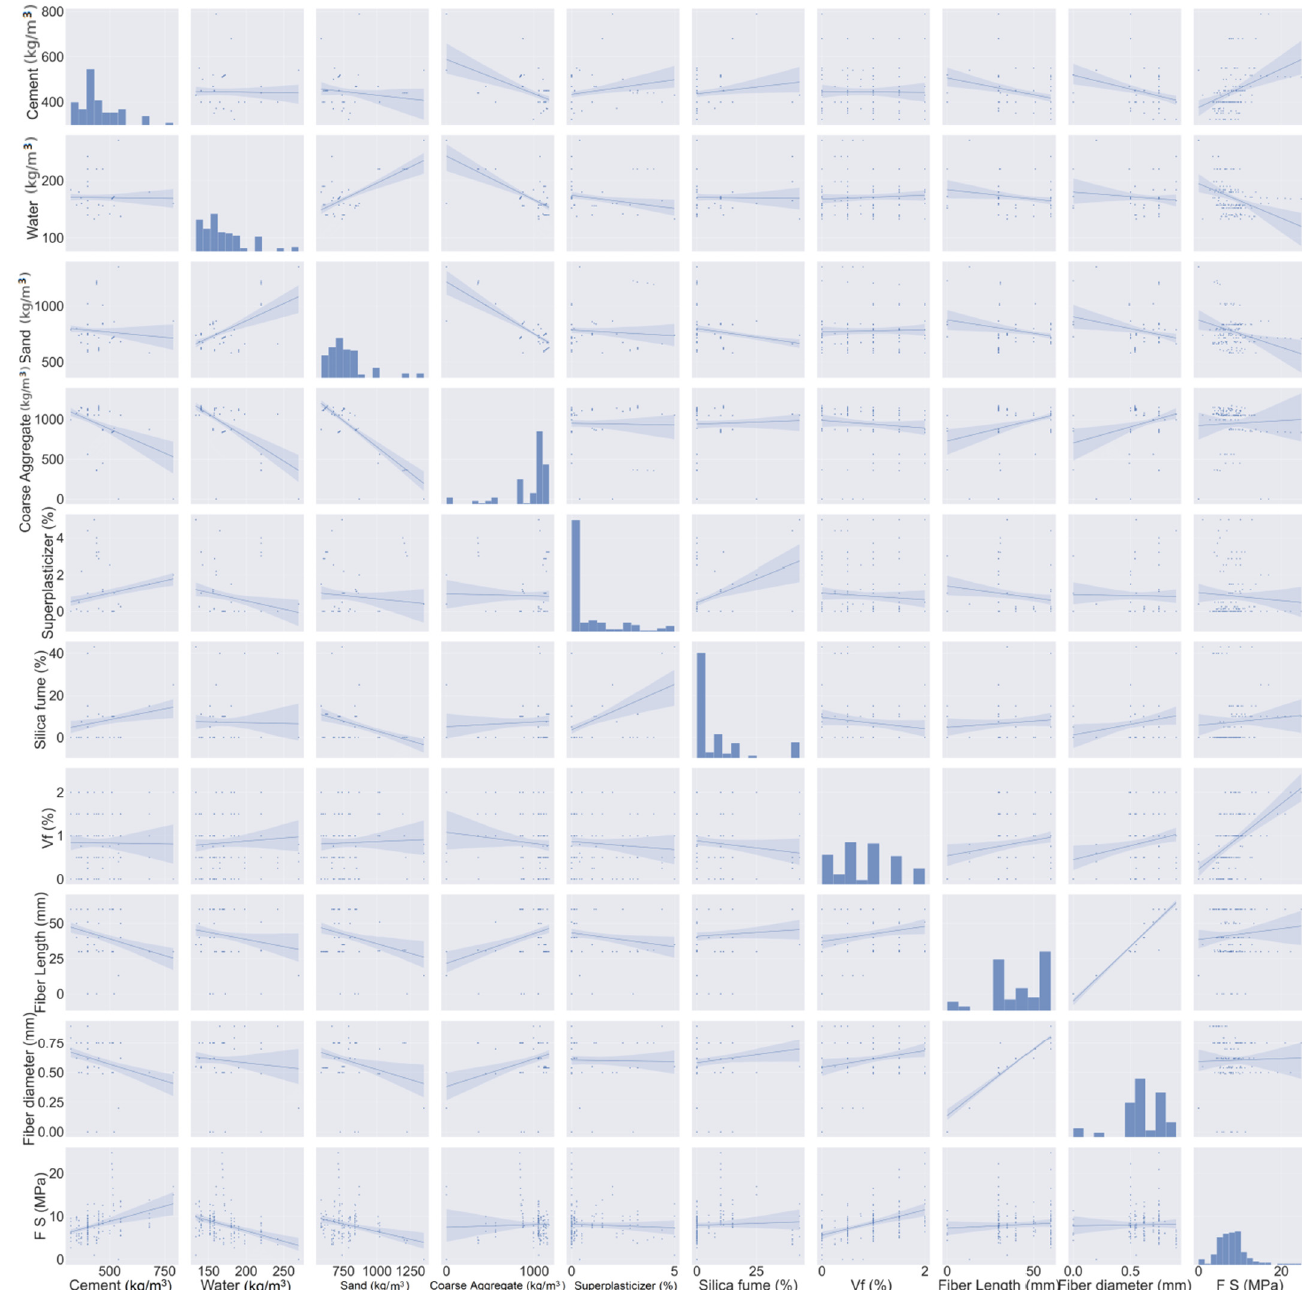
Figure 2. Input and output parameters.